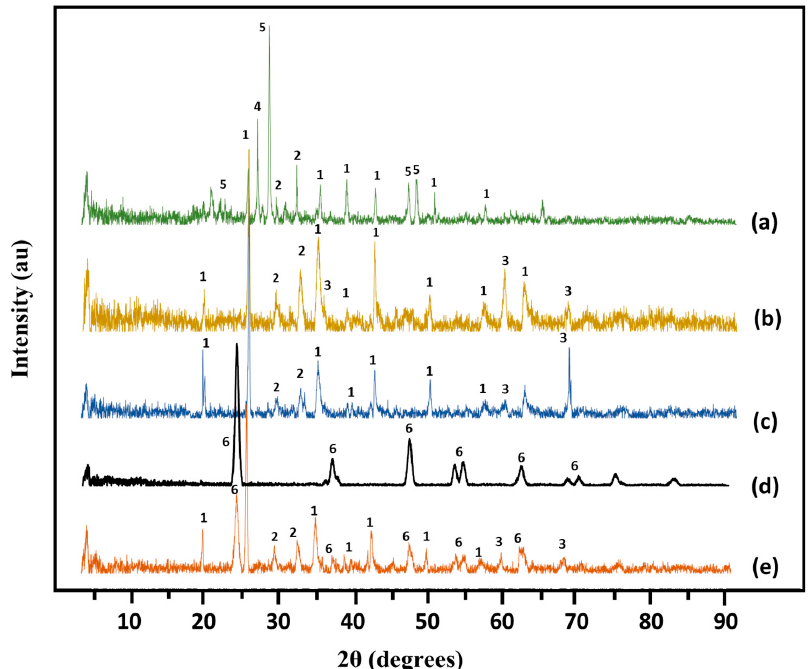
Figure 3. Scanning electron microscopy (SEM) image (left) and energy dispersive x-ray (EDX) spectra (right) of ( a ) geopolymer (GP) and ( b ) TiO 2 -coated GP (GP + TiO 2 ). (Inset of SEM image: actual image of GP spheres).